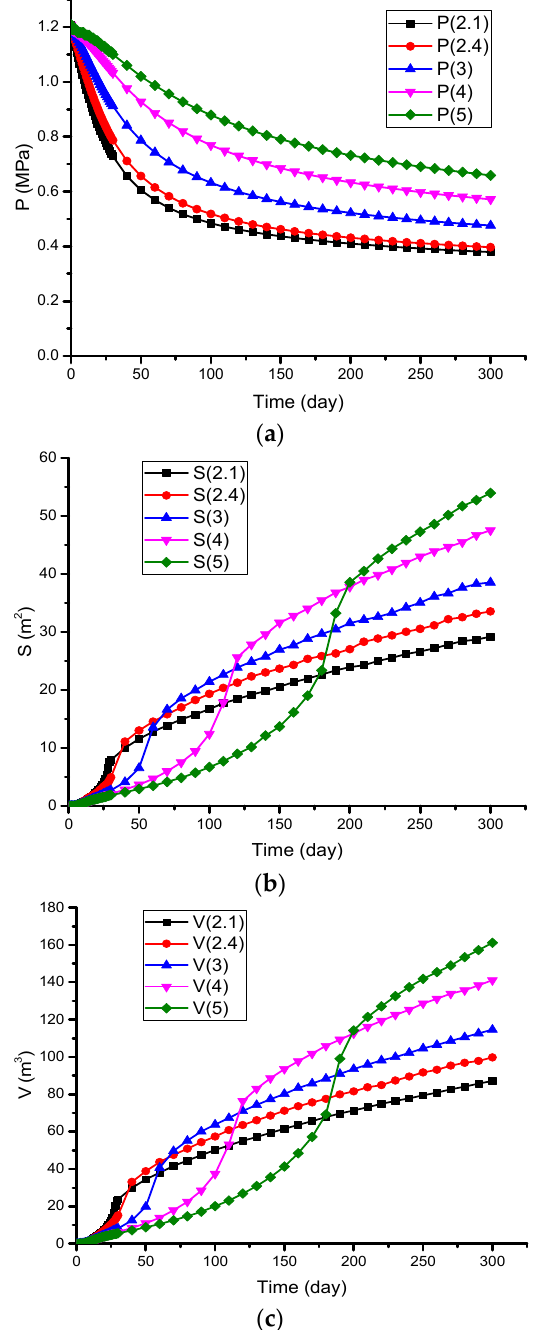
Figure 6. ( a ) Gas pressure at P, ( b ) outburst elimination areas, and ( c ) outburst elimination volume for different borehole spacings.